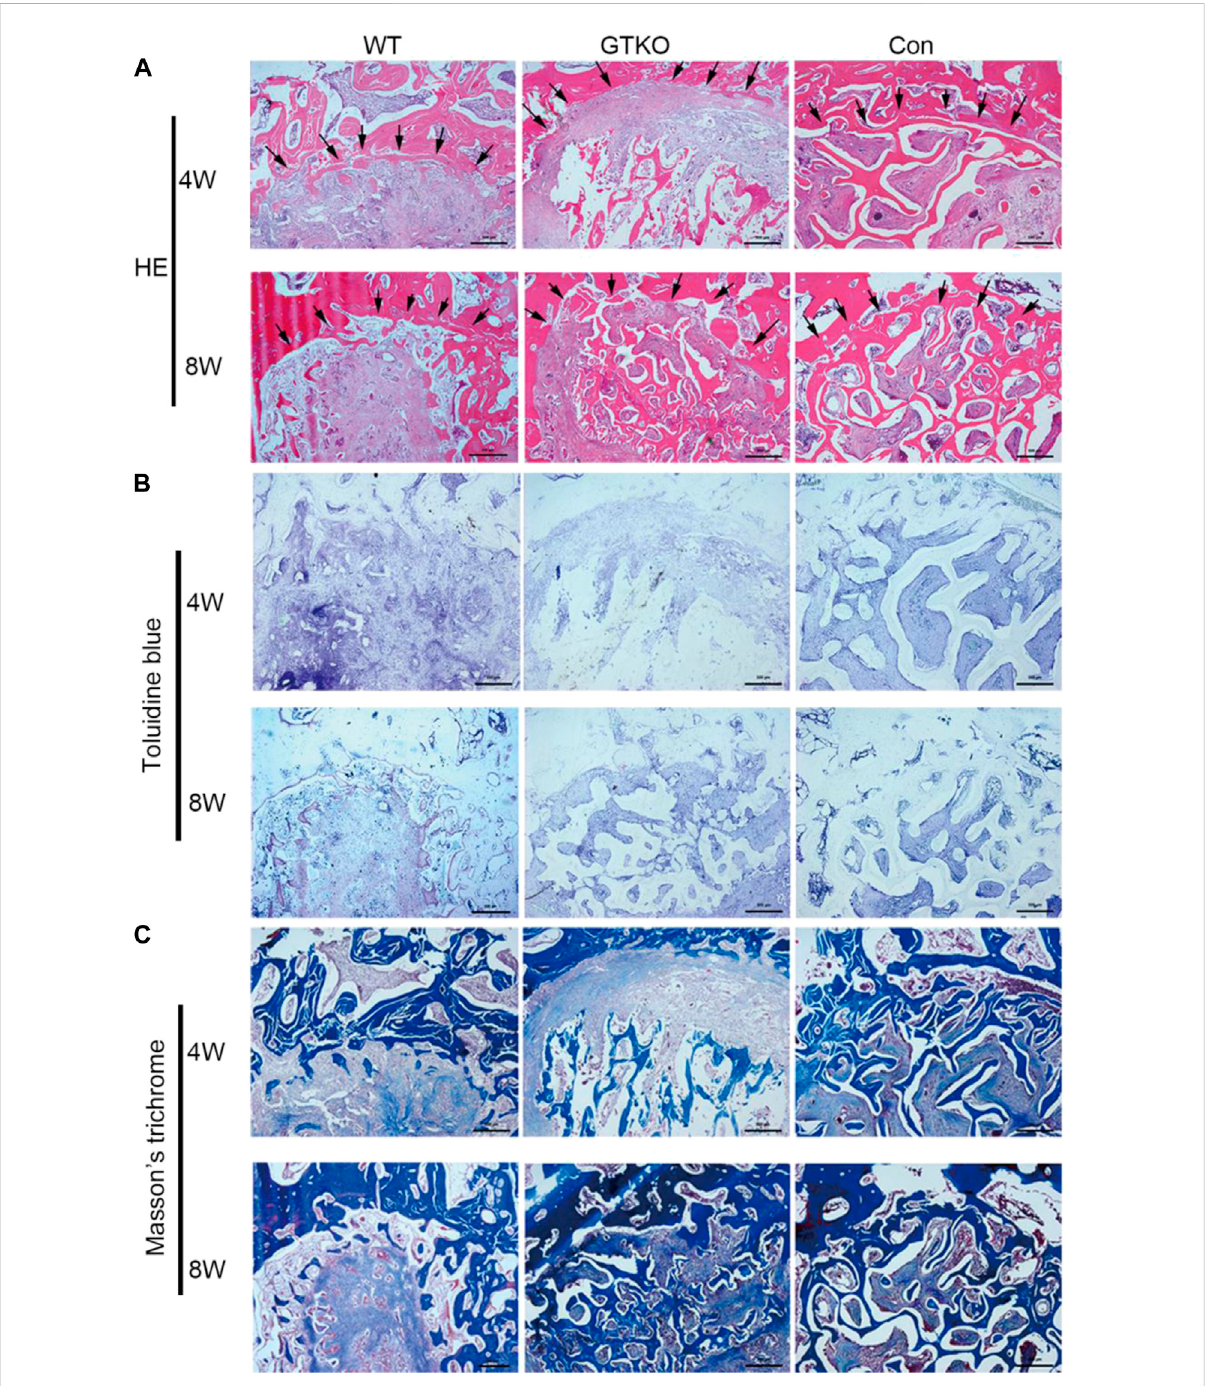
FIGURE 3 Histochemicalassessment. (A) HE staining ofthe bone defect areas transplanted with thematerialsshown at4 and 8 weeks after surgery (×25). Arrows indicate therhesus monkey trabeculaeon theedgeofthebone defect. (B) Toluidine bluestaining ofthebonedefectareastransplanted with the materials shown at 4 and 8 weeks after surgery (×25); (C) Masson ’ s trichrome staining of the bone defect areas transplanted with the speci fi c materials 4 and 8 weeks after surgery (×25). Scale bar, 500 μ